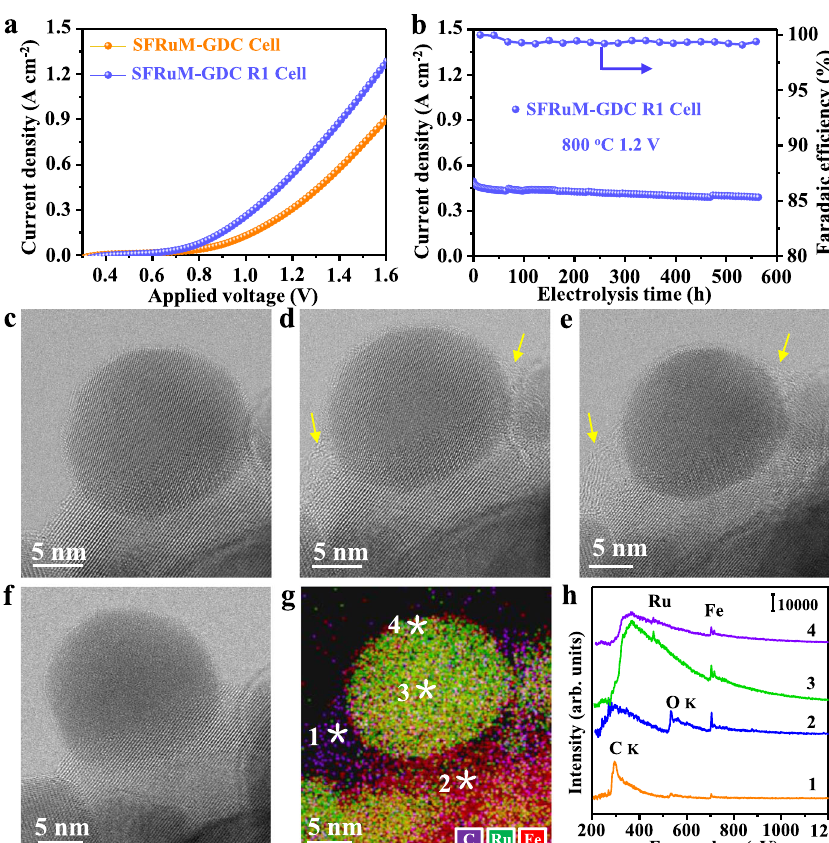
Fig. 4 CO 2 electrolysis and in situ STEM results. a I – V curves of SFRuM-GDC and SFRuM-GDC R1 cells at 800°C. b Stability test of SFRuM-GDC R1 cell and CO Faradaic ef fi ciencies at 800 °C and 1.2 V. In situ BF-STEM images of SFRuM after in situ reduction at 800 °C for ~1 h ( c ), after exposed to 10 Pa of CO 2 for 10 min at 200 °C ( d ), after exposed to 10 Pa of CO 2 for 30 min at 200 °C ( e ) (The adsorbed species are indicated by yellow arrows), and after heating up to 800 °C under vacuum ( f ). g , h In situ STEM-EDS map and in situ STEM-EELS spectra of ( e